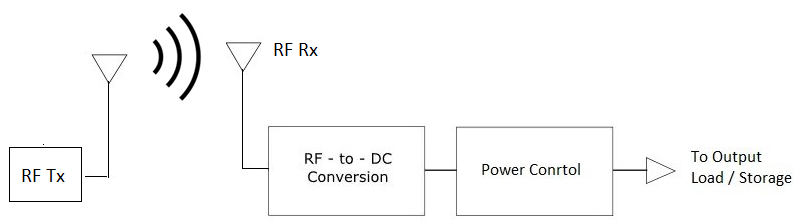
Figure 1. RF energy harvesting